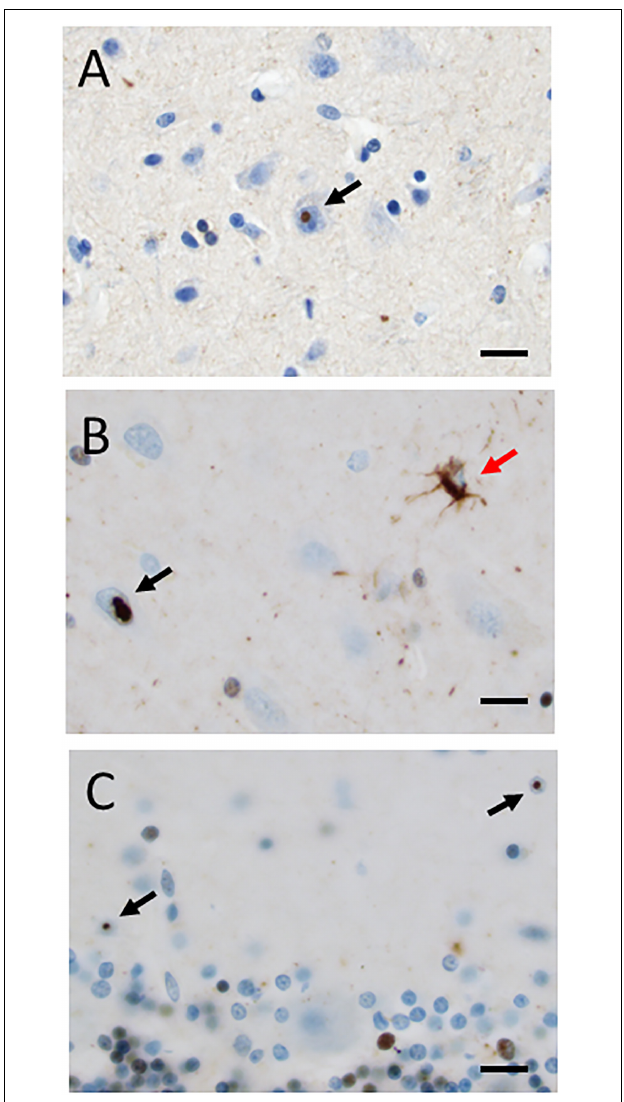
FIGURE 2 | (A–C) Ubiquitin-positive intranuclear inclusions (black arrows) in neurons in frontal cortex (A) , hippocampus (B) , and cerebellum (C) . A red arrow in (B) indicates an ubiquitin-positive tufted astrocyte. Scale bars: 25 µ m.